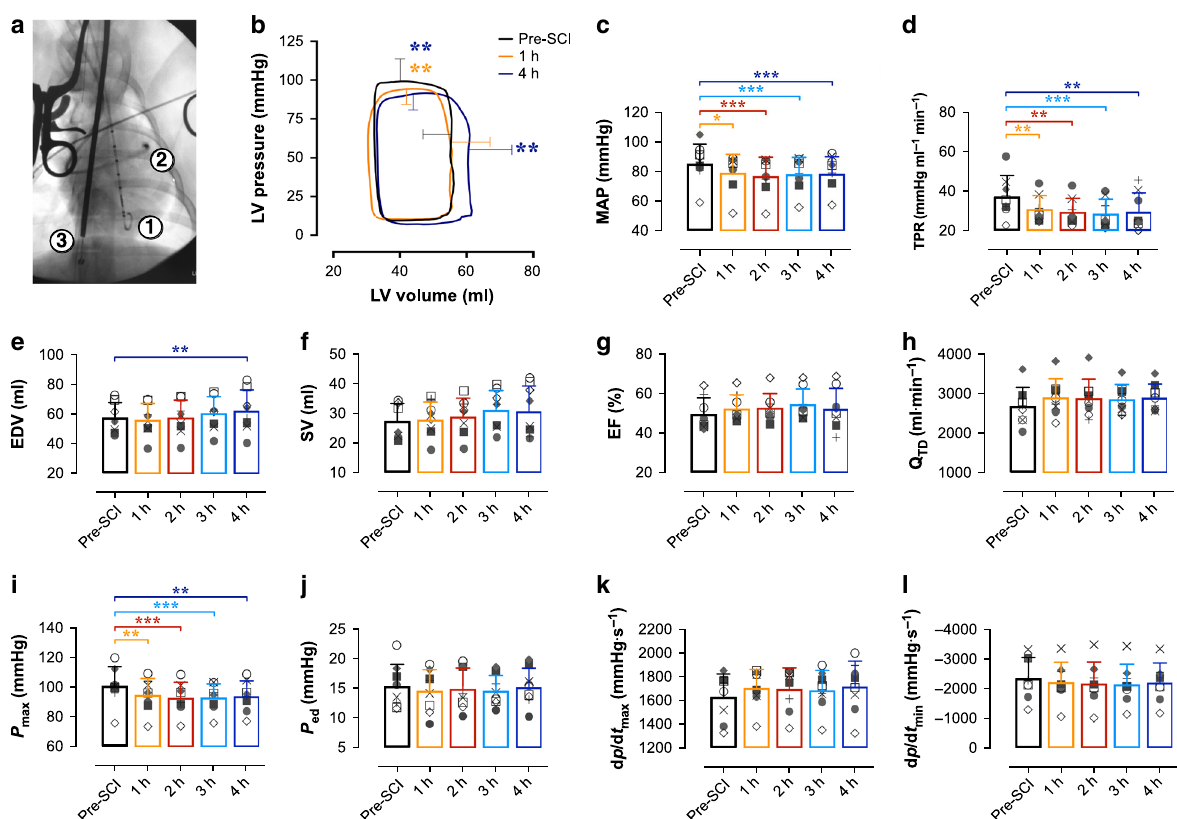
Fig. 1 Load-dependent LV function and hemodynamics in acute T2 SCI. a In experiment 1, n = 8 animals were instrumented with a LV pressure-volume admittance catheter [1], Swan-Ganz catheter [2] advanced to the pulmonary artery, and a balloon-tip inferior vena cava (IVC) occlusion catheter [3] for transient reductions to preload and assessments of LV end-systolic elastance ( E es ). b Basal pressure-volume loops represent mean interpolated data and error bars represent standard deviation (s.d.) for peak systolic pressure (P max ) and end-diastolic volume (EDV) at baseline (pre-SCI, black), 1 h (orange) and 4 h (blue) post-SCI. P max was reduced within the fi rst hour post-SCI ( p = 0.0064) and remained lowered up to 4 h post-SCI ( p = 0.0021). EDV was increased compared to pre-SCI at 4 h ( p = 0.0038), though LV stroke volume (SV) was not signi fi cantly altered by the experiment endpoint. c Bar plots represent means, error bars show s.d., and symbols represent individual animal data. Mean arterial pressure (MAP) and d total peripheral resistance (TPR) were reduced within the fi rst hour post-SCI ( p = 0.0020 and 0.0067, respectively), and those reductions were sustained up to 4 h post-SCI ( p ≤ 0.001 for both). e While EDV was augmented at 4 h post-SCI ( p = 0.0038), f SV, g ejection fraction (EF), and h cardiac output (Q TD ) were unchanged